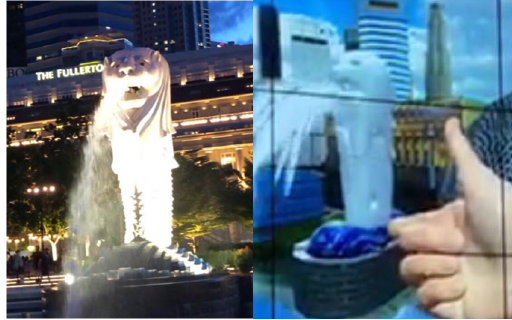
Figure 3. Physical Merlion ( left ) and virtual Merlion ( right ).